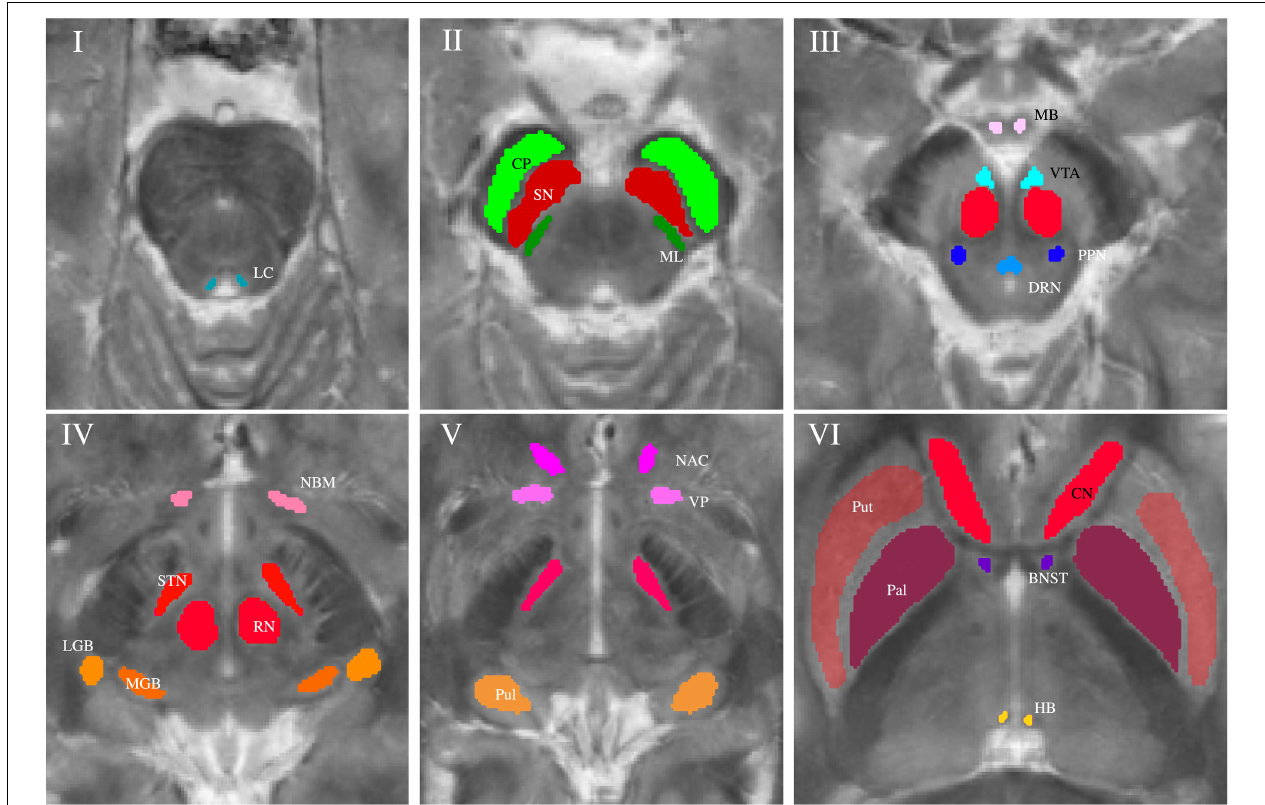
FIGURE 1 | Volumes of interest (VOIs) are indicated on axial QSM/MT overlay images numerated from caudally to cranially in ascending order. VOIs of fiber tracts (CP and ML) are colored in shades of green in Slice II. VOIs of (epi-)thalamic nuclei (LGB, MGB, HB, and Pul) are colored in shades of yellow in Slices IV and V, VOIs of limbic nuclei (BNST, NAC, VP, MB, and NBM) are colored in shades of pink in Slices III-VI and, VOIs of nuclei of the ARAS (DTN, PPN, VTA, and LC) in shades of blue in Slices I and III. VOIs of extrapyramidal nuclei (NC, RN, PAL, Put, SN, and STN) are colored in shades of red in Slices II to VI.